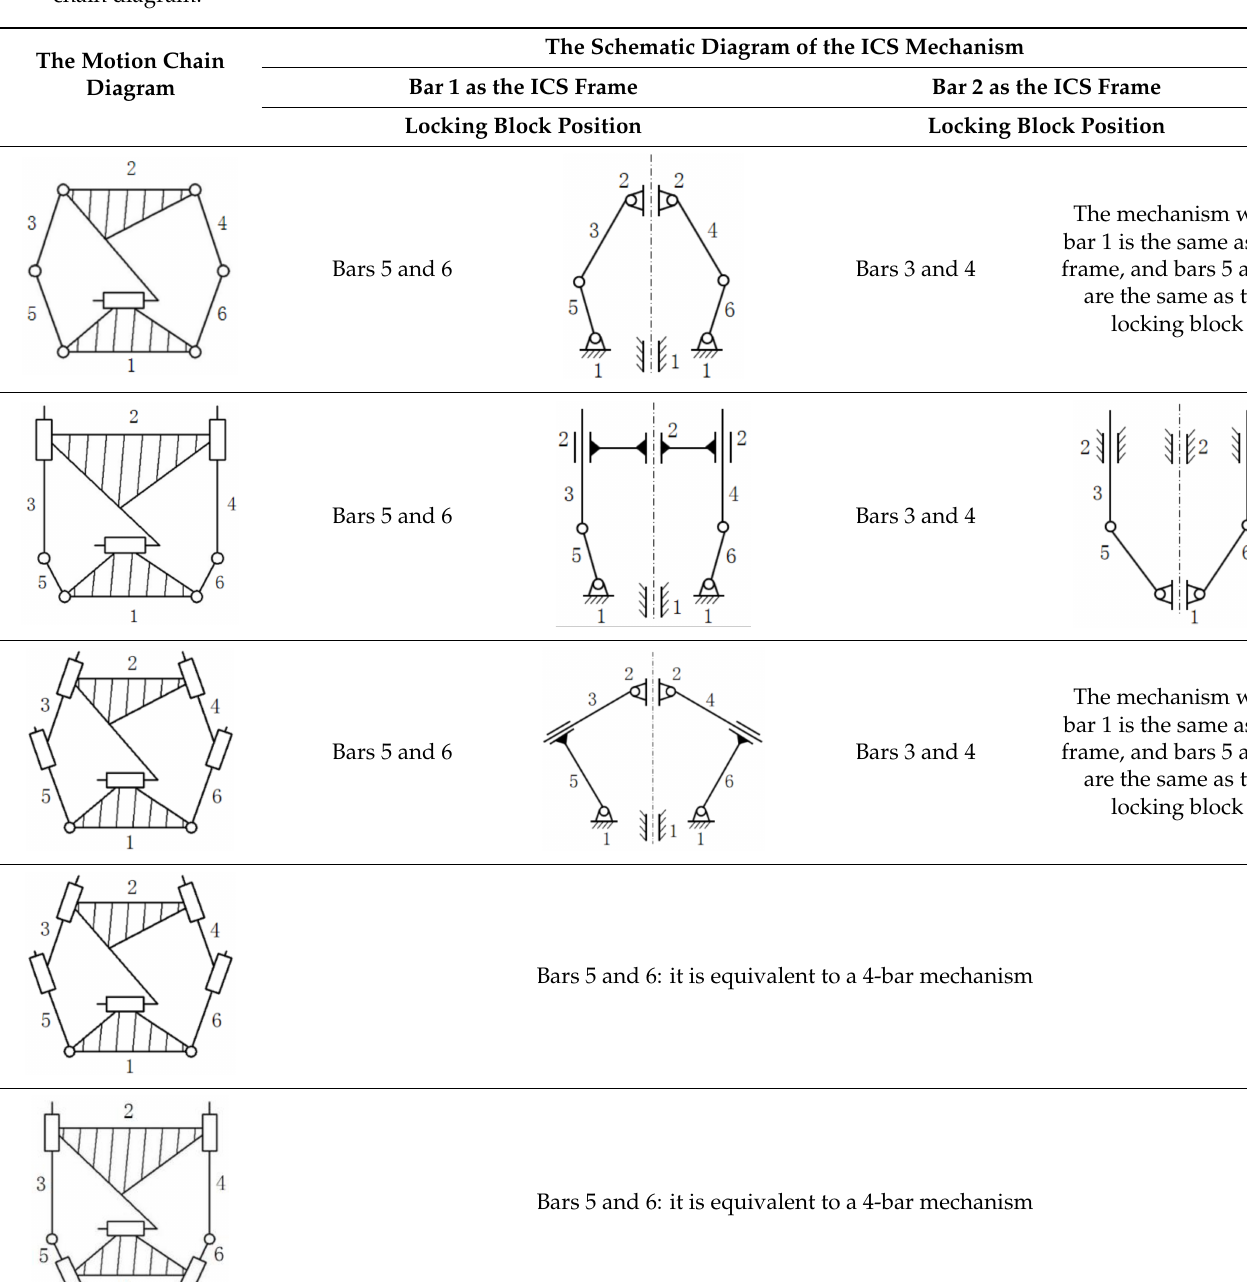
Table 1. Relation table between the schematic diagram of the integrated cutter system (ICS) mechanism and the motion chain